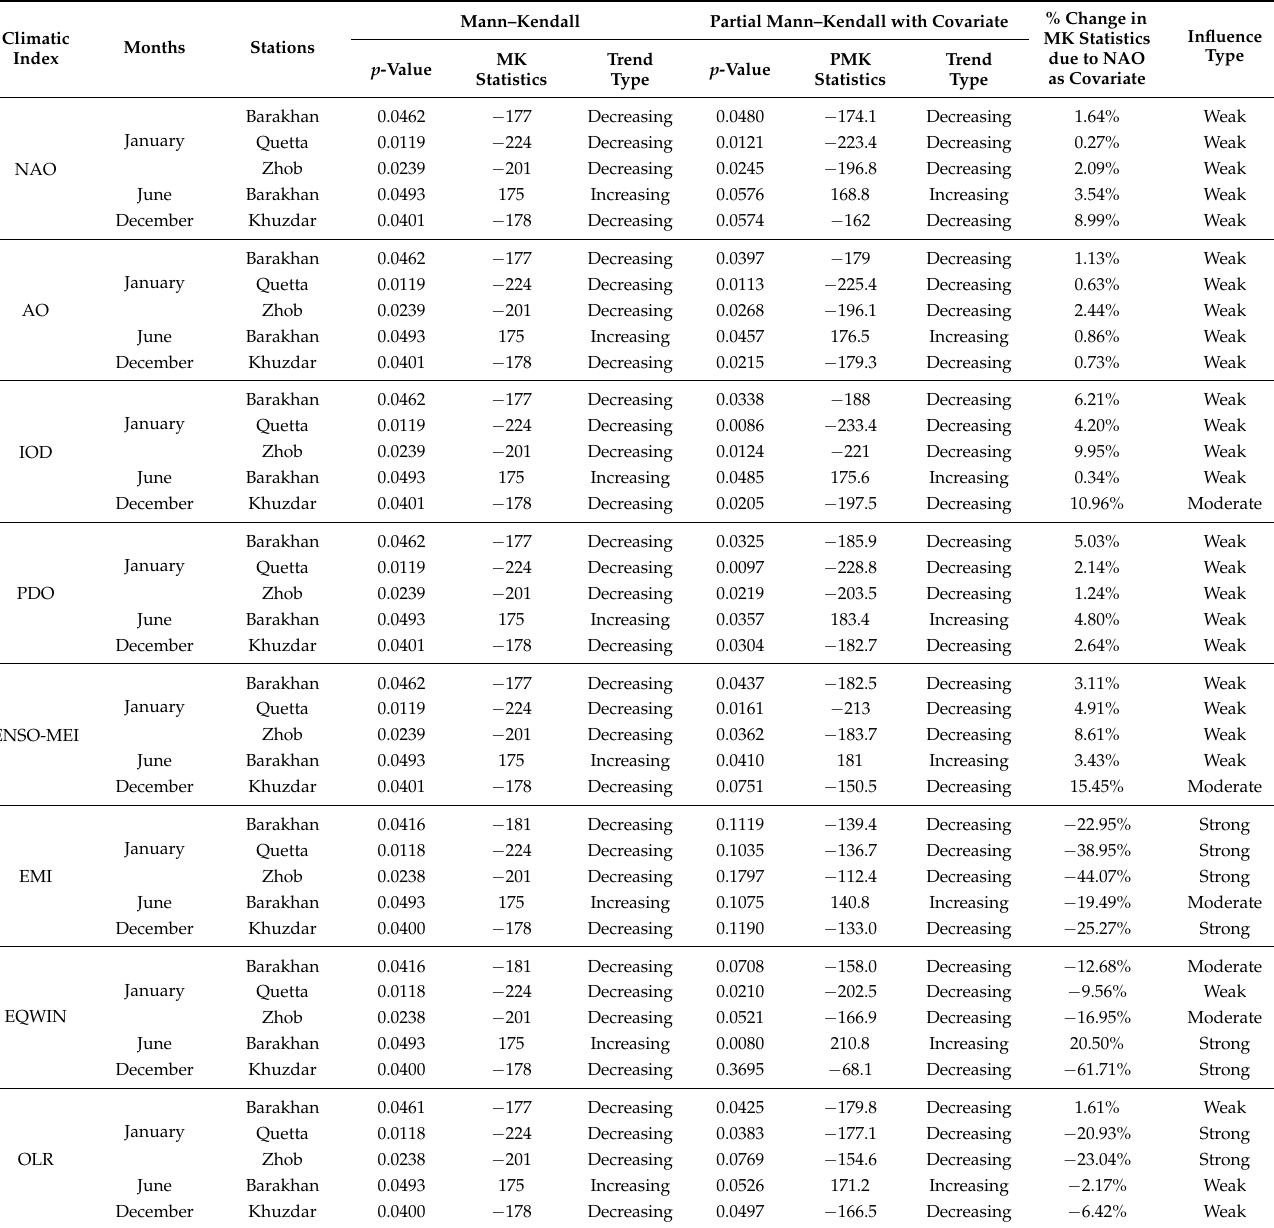
Table 6. Influence of the climatic index on precipitation